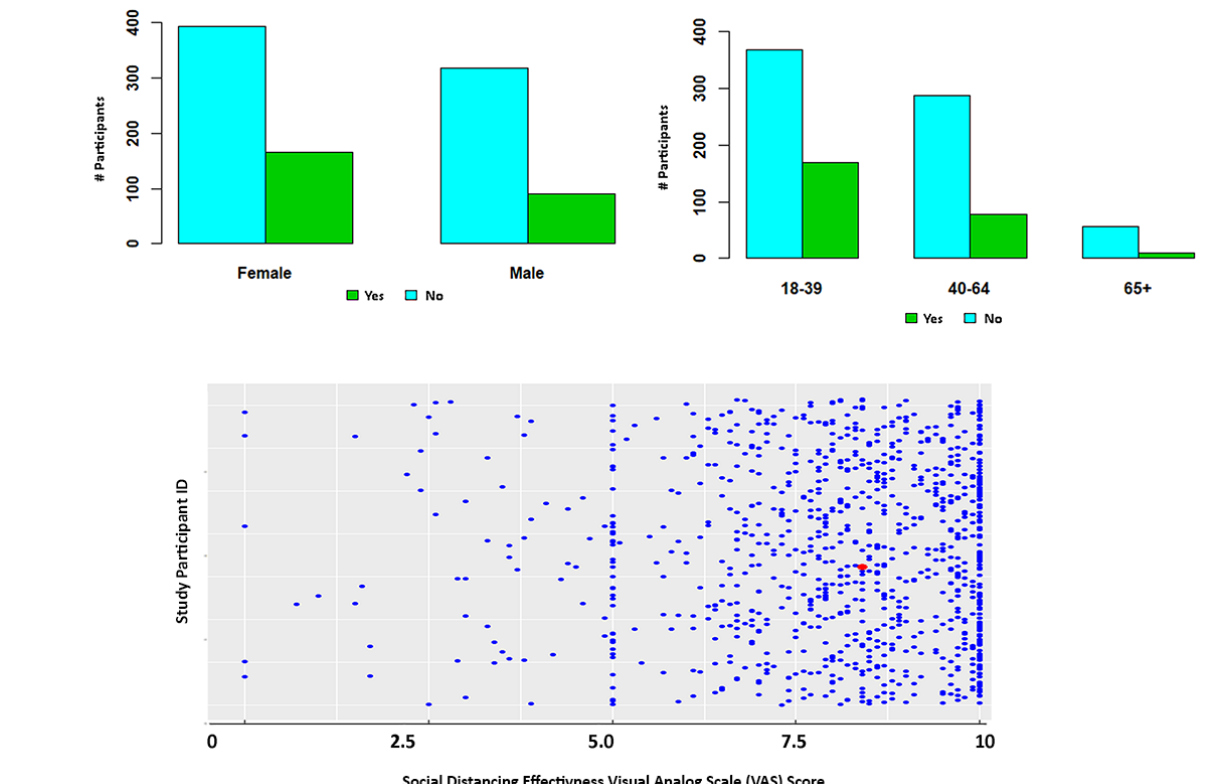
Figure 3. Survey response to “has social distancing had a negative impact on your mental health” question across sex and age cohorts, and a scatter plot depicting the visual analog scale scores of how effective people believe social distancing is at addressing the spread of COVID-19 (where 0 is not effective at all, and 10 is most effective), with a mean of 7.98 (SD 1.94) and a median of 8.40 (red